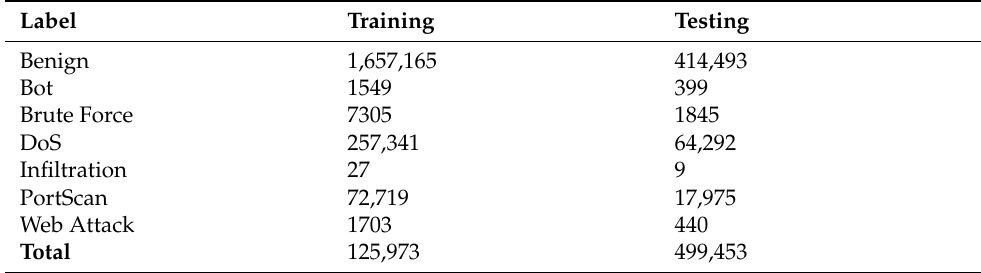
Table 4. Distribution of data on CIC-IDS2017 (the number of